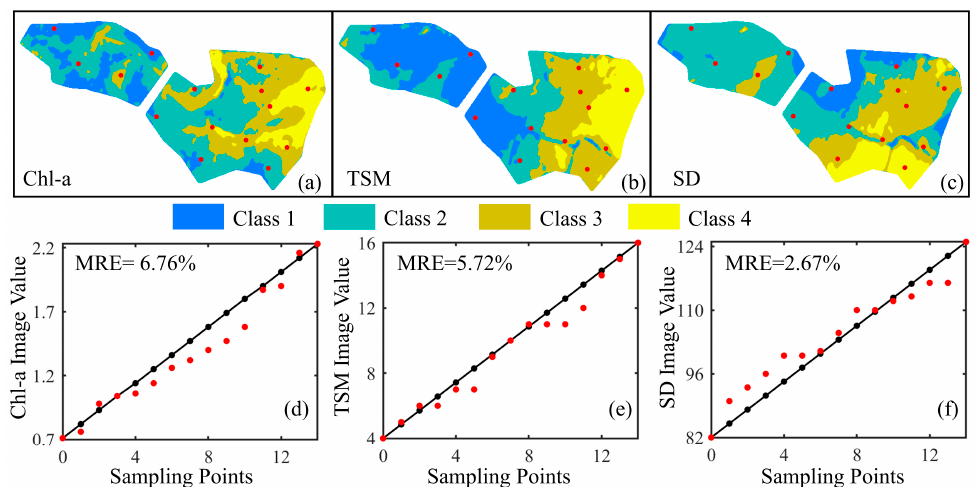
Figure 9. Multi-parameter sampling points in Nanyi lake ( a – c ), and the MRE of the in-situ and sim- ulated data ( d–f ), and the black dots are the simulated data, and the red dots are the in-situ data.